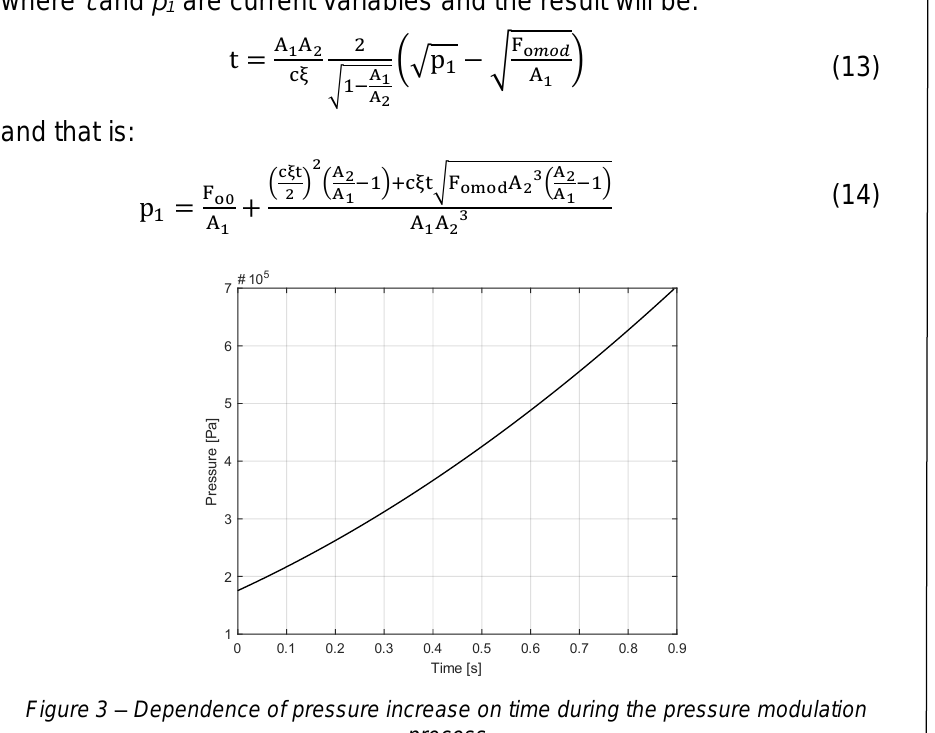
Figure 3 – Dependence of pressure increase on time during the pressure modulation process Рис. 3 – Повышение давления в зависимости от времени процесса